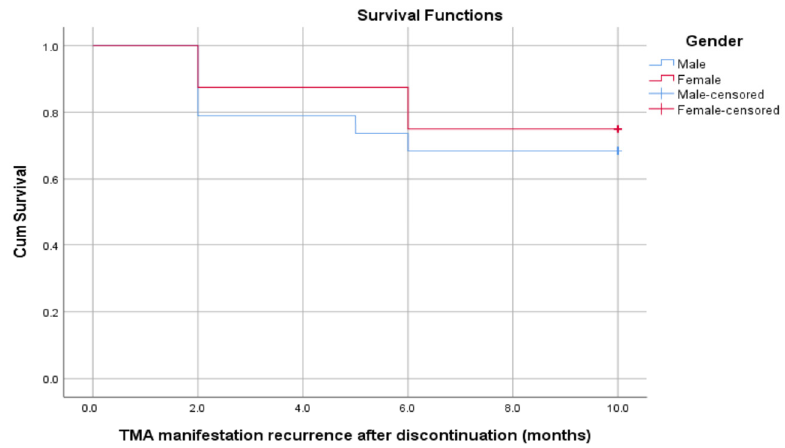
Figure 2. Survival plot for the times to relapse between males and females.